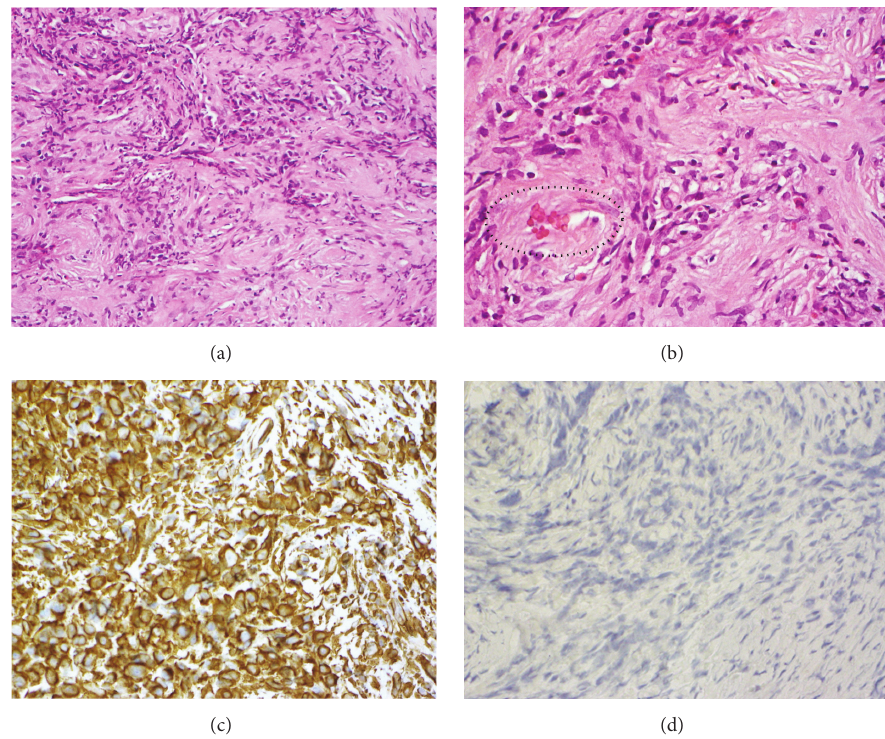
Figure 1: (a) Histology of the dense collagenous sclerosing lesion with acute and chronic inflammatory cells (10x objective). (b) Histology demonstratingsignificant numbersofeosinophilsintheinflammatoryinfiltratewhich surroundsa vessel(circled) (40xobjective). (c)Positive staining of the lesion’s cells for vimentin with immunohistochemistry (40x objective). (d) Negative staining for S100 and AE1/AE3 (40x objective).